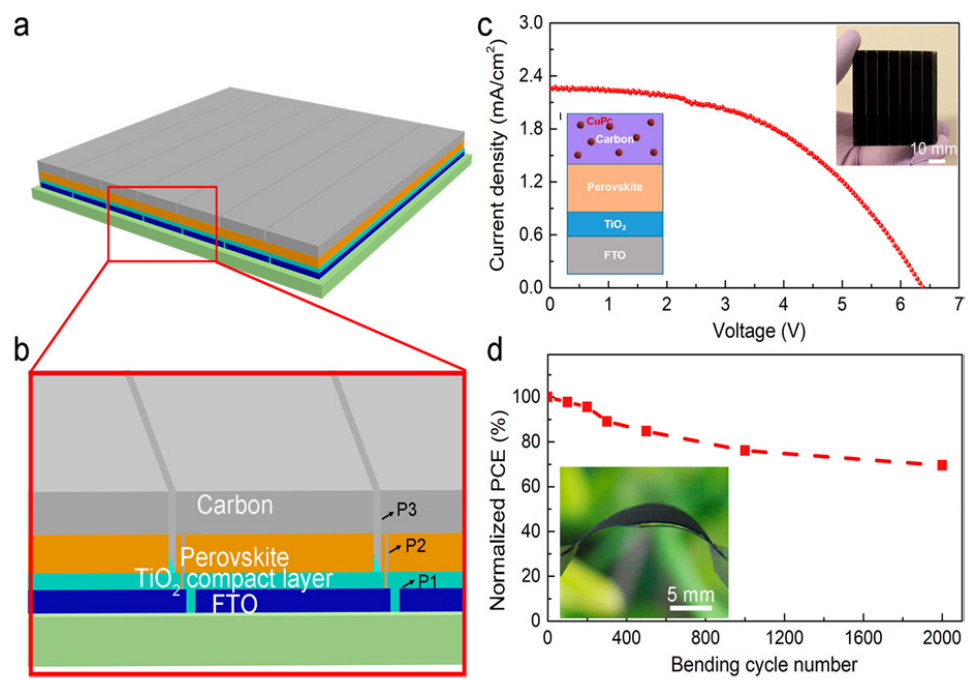
Figure 32. Scalable fabrication of the carbon-based PSC modules. ( a , b ) Schematic figure of the module structure. ( c ) J–V curve of the as-prepared PSC module on a 5 cm × 5 cm FTO substrate with 22.4 cm 2 designated area (inset: photograph of solar module with the carbon electrode). ( d ) Dependence of the PCE change of the PSC on a flexible substrate on the increasing bending cycle number (inset: photograph of a solar module in bending conditions) [109]. (Reproduced from Ref. [109], 10.1021/acsenergylett.9b01294, under the terms of the CC BY-NC-ND [4.0] license.)